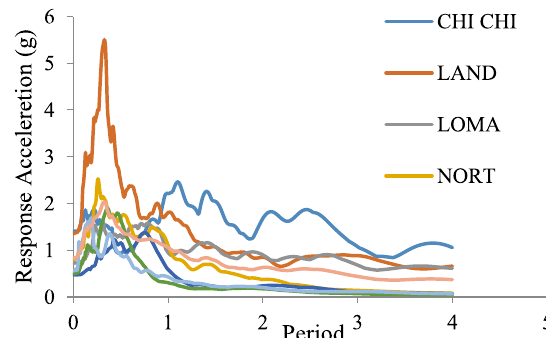
Fig. 4 The response spectrums of selected seven earthquakes